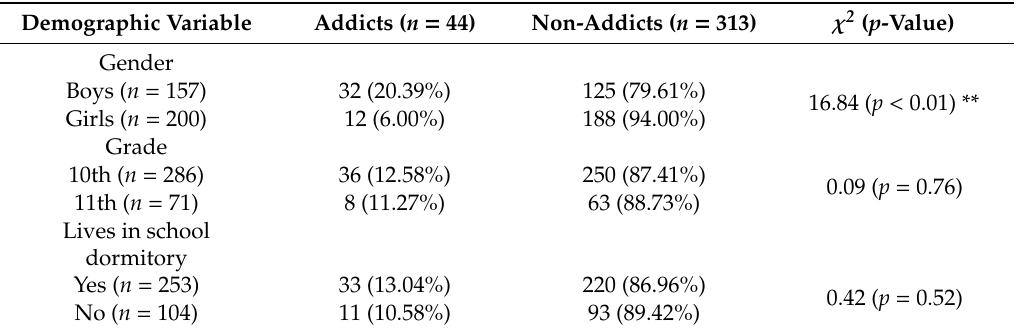
Table 2. Di ff erences between addicts and non-addicts in terms of demographic variables.